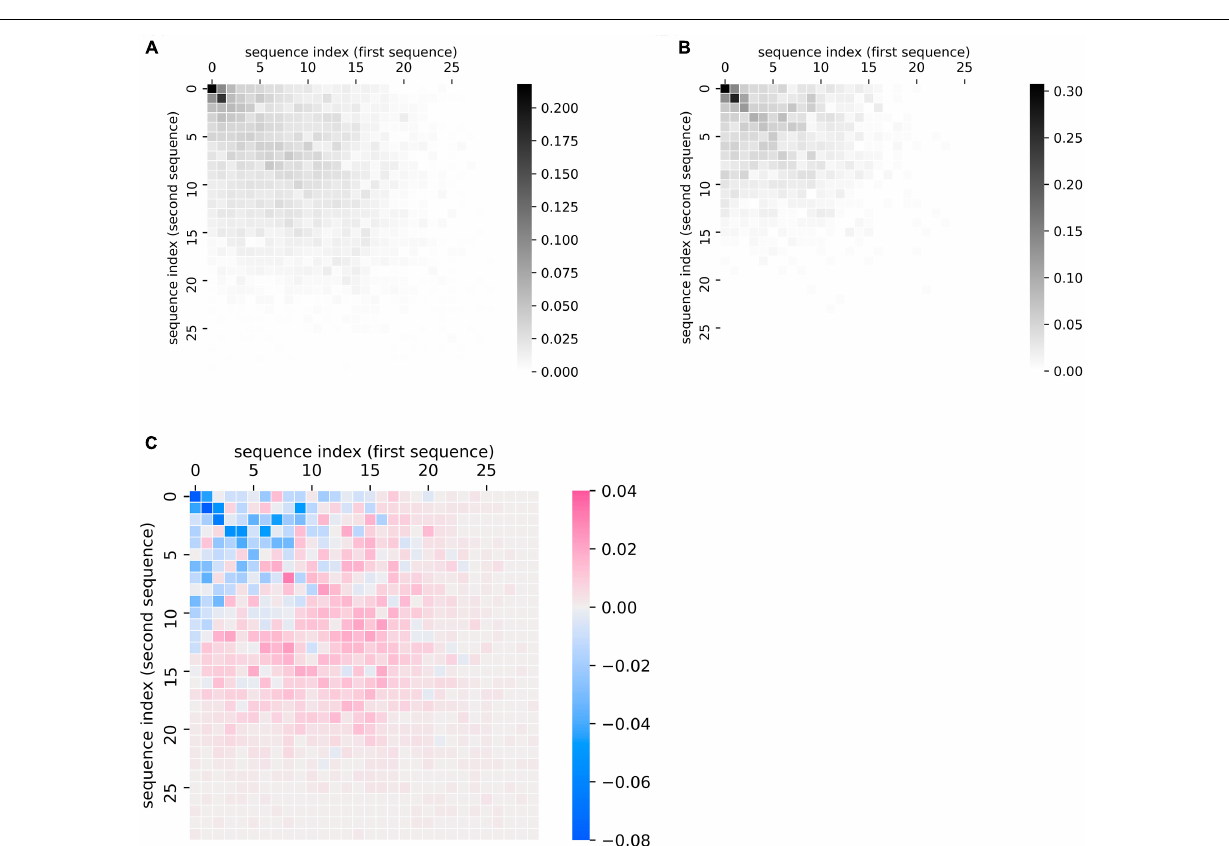
Frontiers in Aging Neuroscience |